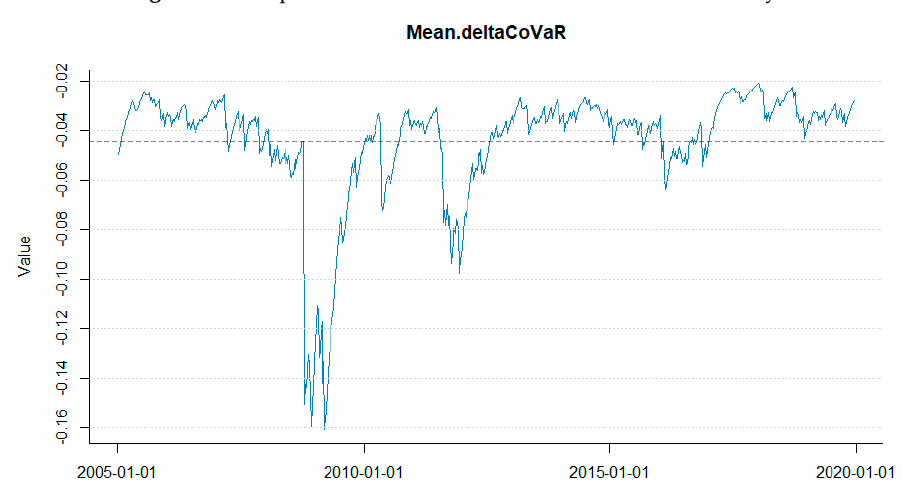
Figure 14. Sample MSTs in two chosen times. Source: Own study.